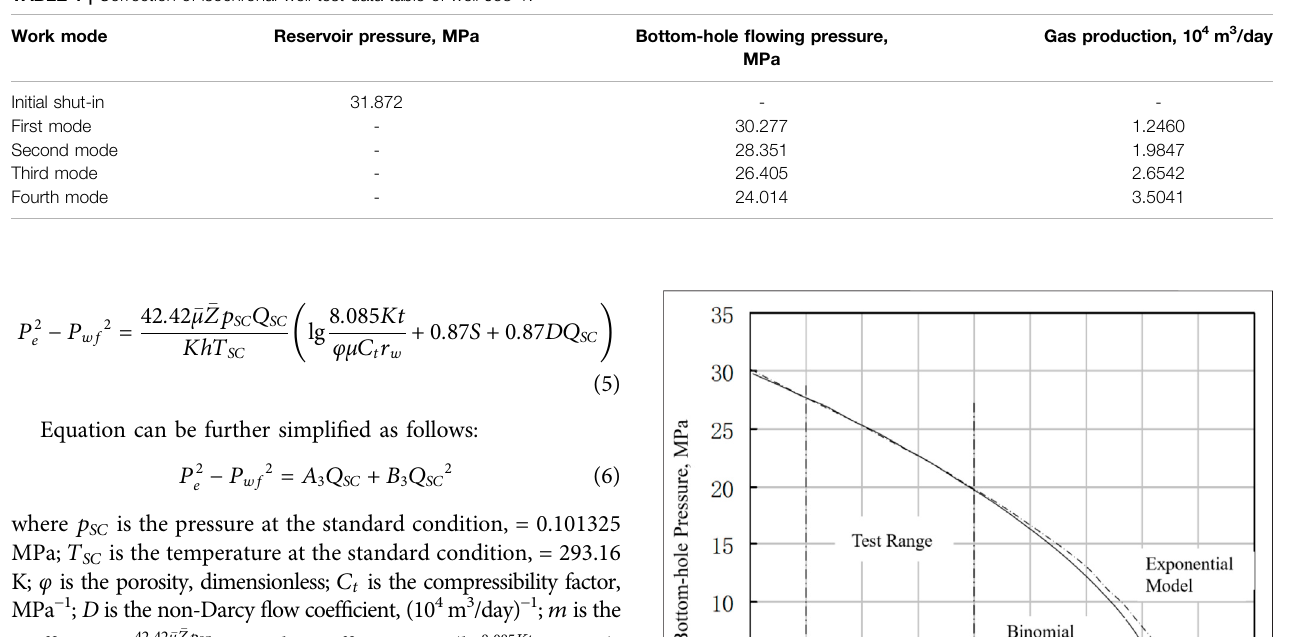
TABLE 1 | Correction of isochronal well test data table of well J53-1.